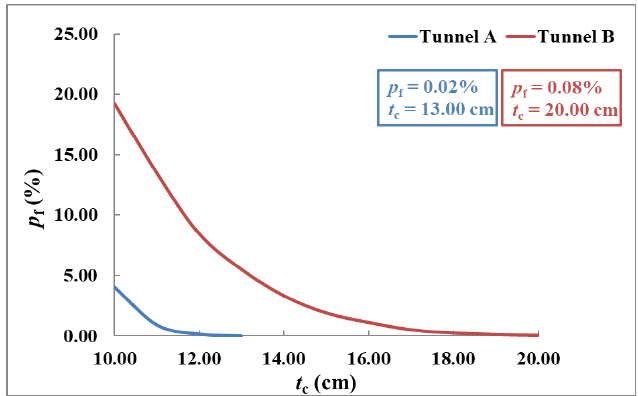
Figure 9. Failure probability reduction with the increasing of c t , concerning the performance function ( ) 2 g x .